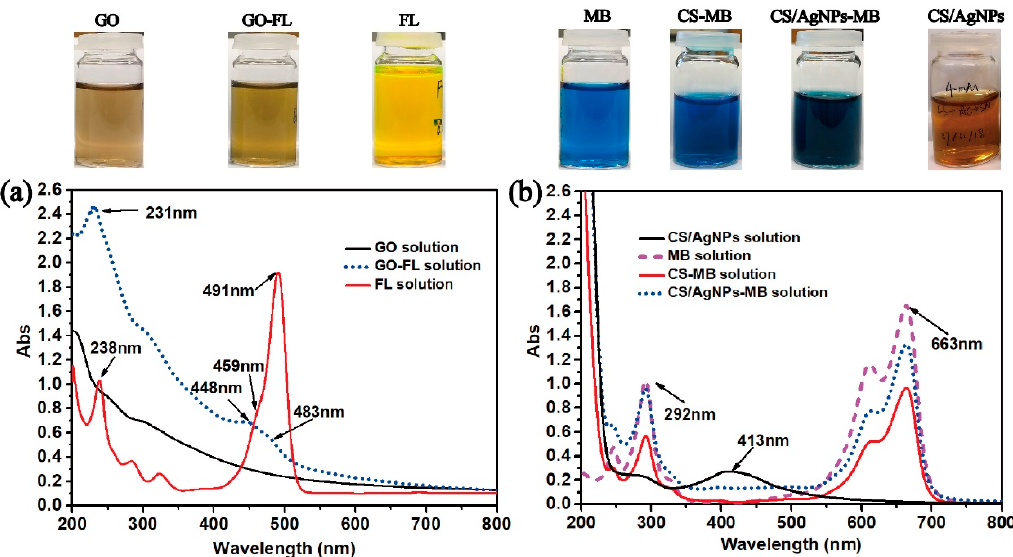
Figure 4. ( a ) UV-vis spectra of GO, GO-FL, and FL solutions, and ( b ) MB, CS/AgNPs-MB, CS-MB, and CS/AgNPs solutions. Inset—photos showing colors of each as-prepared solution.